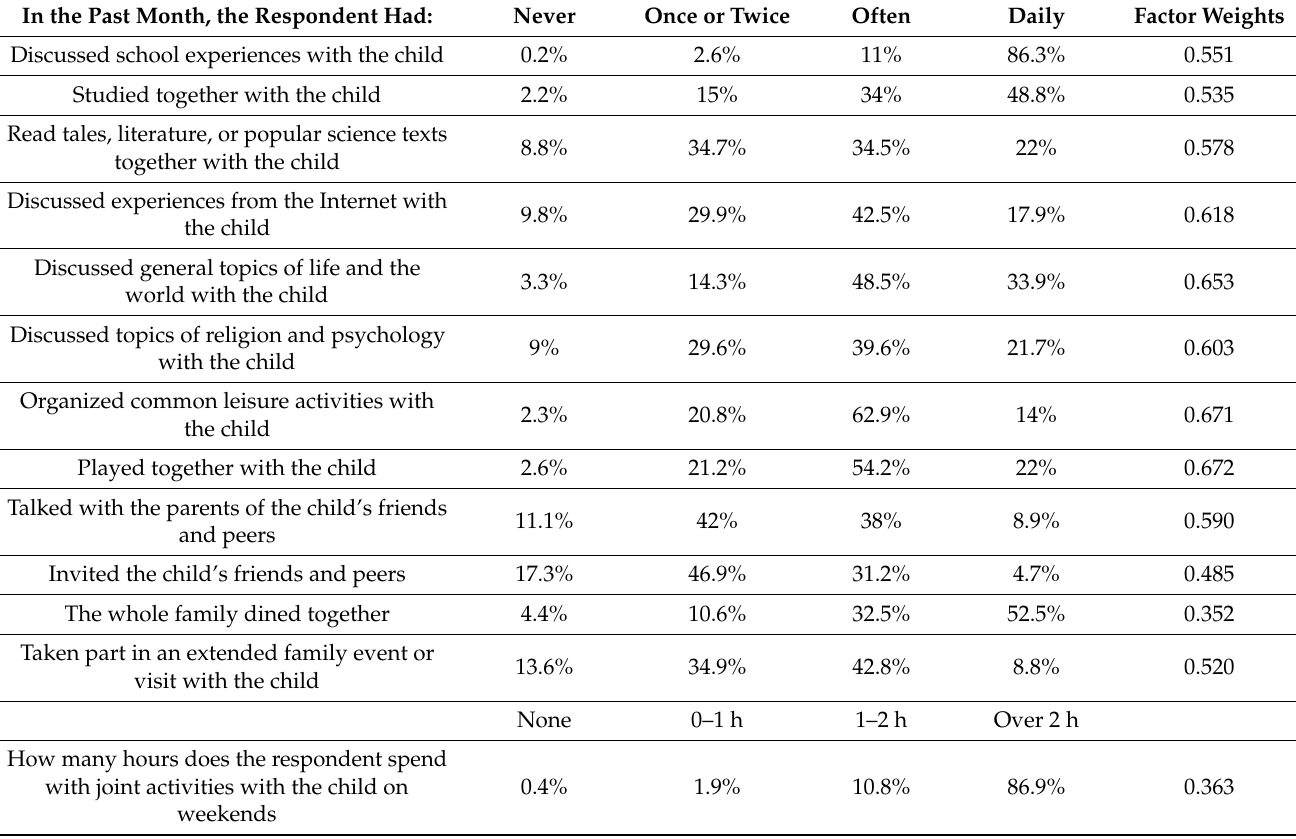
Table A1. Descriptive statistics of the items of the parental attention principal component and factor